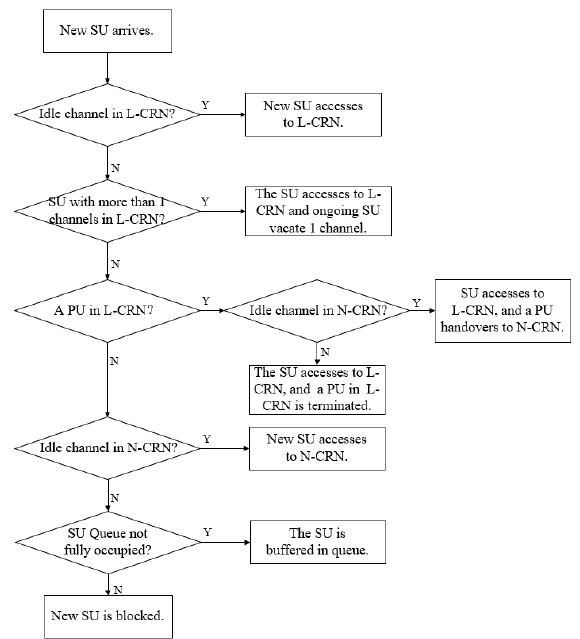
Figure 4. The procedure when a new secondary user (SU)